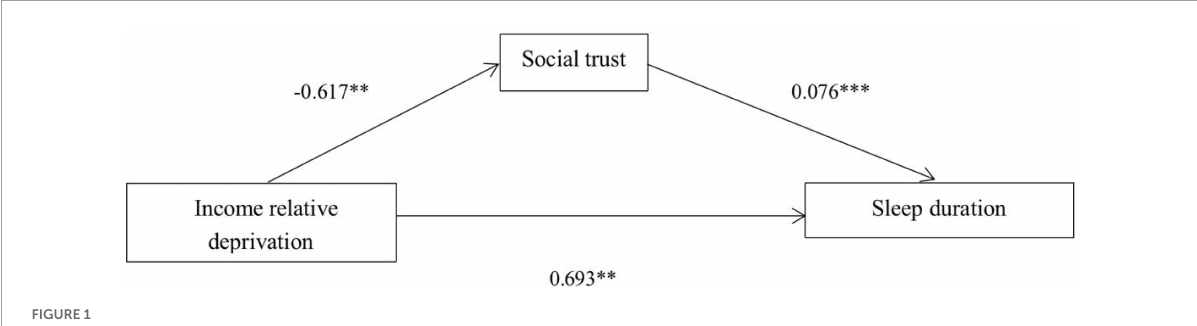
FIGURE1 Mediation model of social trust. ∗ p < 0.1; ∗∗ p < 0.05; ∗∗∗ p <